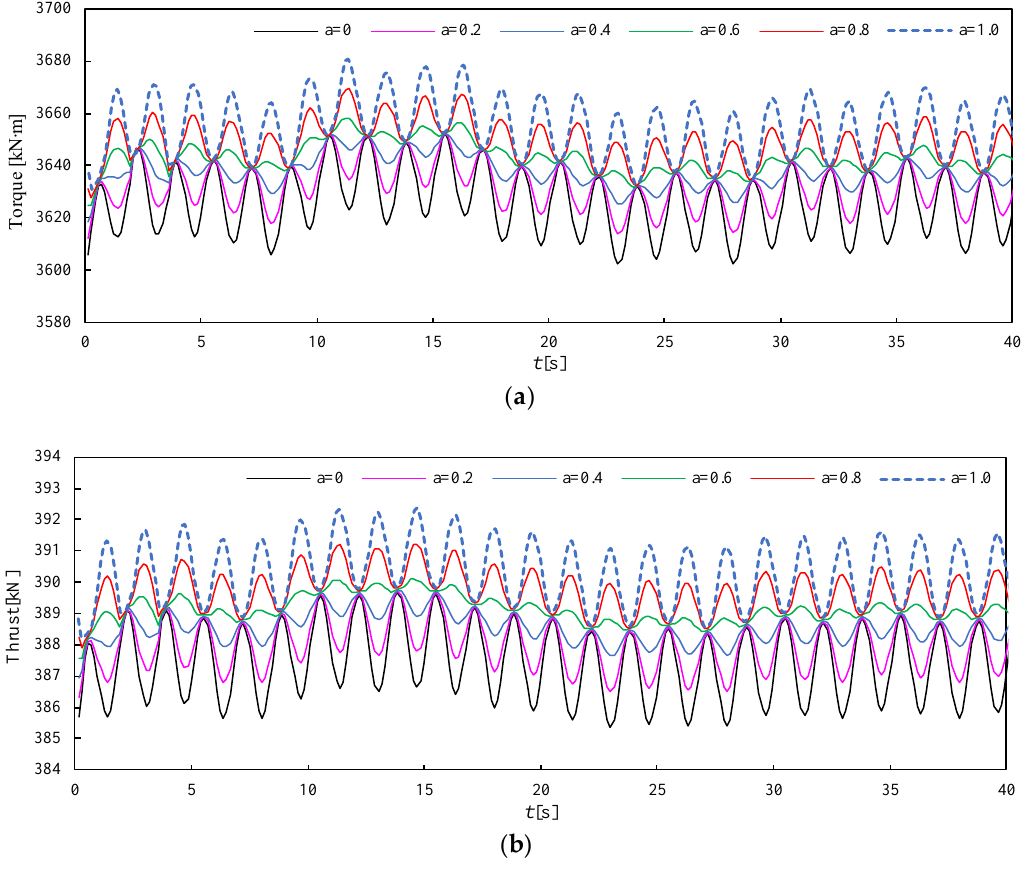
Figure 16. Torque and thrust response of the wind turbine rotor under wind shear conditions for U hub = 16 m/s and θ p = 10.5. ( a ) Torque response; ( b ) Thrust response.